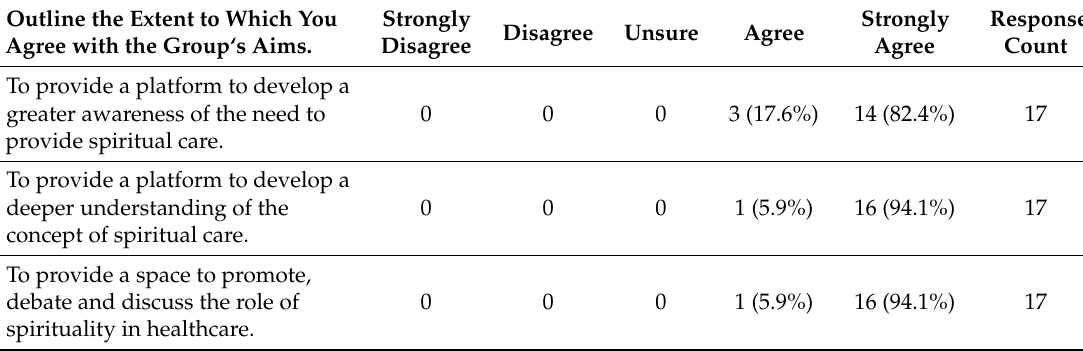
Table 1. The extent to which the SIG members agree with the group’s